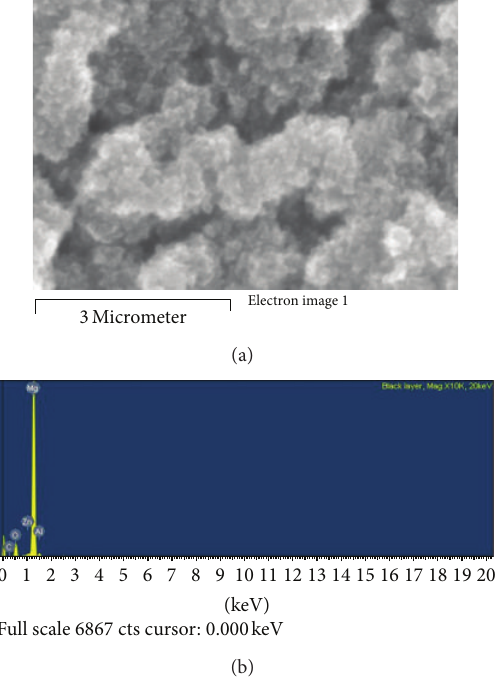
Figure 13: (a) SEM image of the black layer. (b) EDX analysis of the black